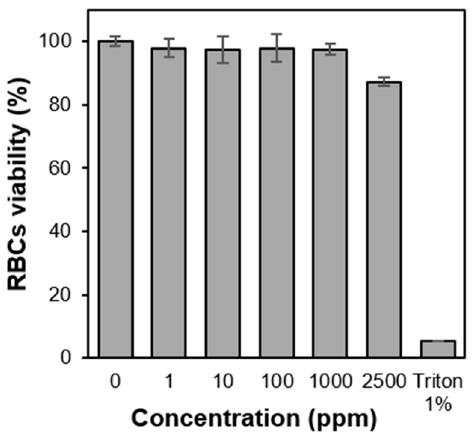
Figure 6. Hemolysis test of PS- b -PIN on RBC cells.